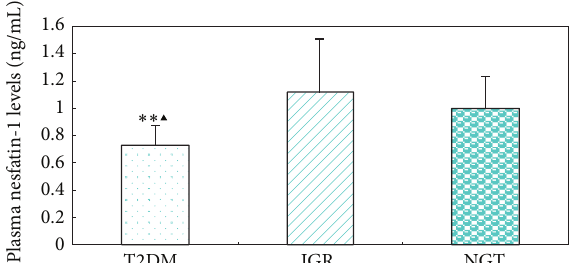
Figure 1: The plasma nesfatin-1 levels in patients with type 2 diabetes mellitus (T2DM) and patients with impaired glucose regulation(IGR)aswellasinthecontrolpeoplewithnormalglucose tolerance (NGT). T2DM versus IGR group, 󳵳 < 0.01; T2DM versus NGT group, ∗∗ < 0.01.